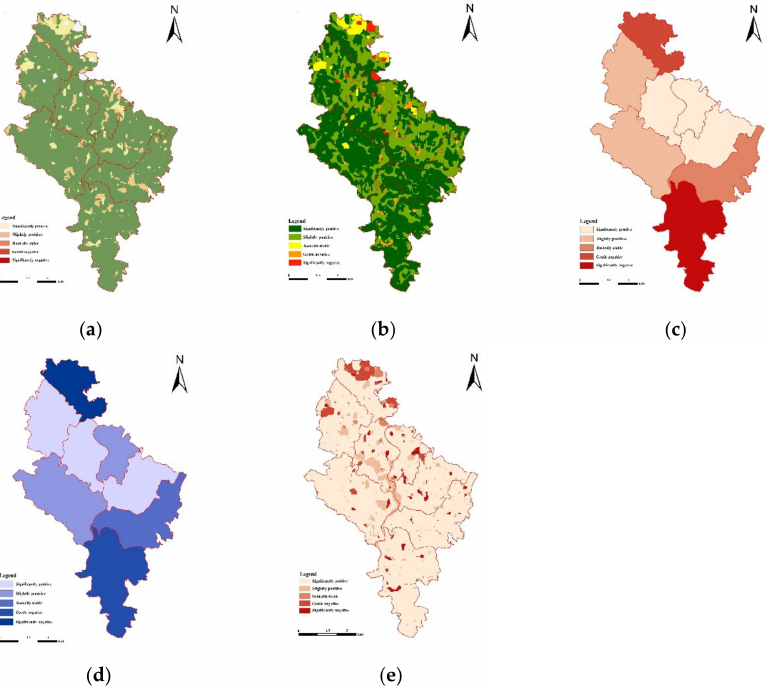
Figure 8. Evaluation results of the ecological environmental effect trend of rural land use from 2019 to 2030 (developmental orientation, DO). ( a ) Resource effect trend 2019–2030; ( b ) environmental effect trend 2019–2030; ( c ) social effect trend 2019–2030; ( d ) economic effect trend 2019–2030; ( e ) ecological environmental effect trend 2019–2030.